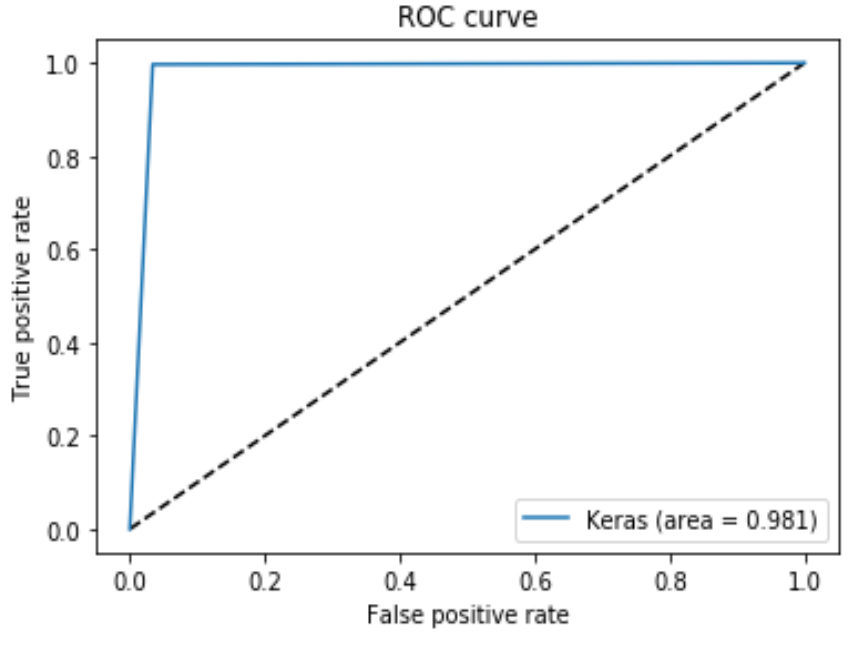
Figure 10: ROC curve for 70% training using BLSTM in time domain